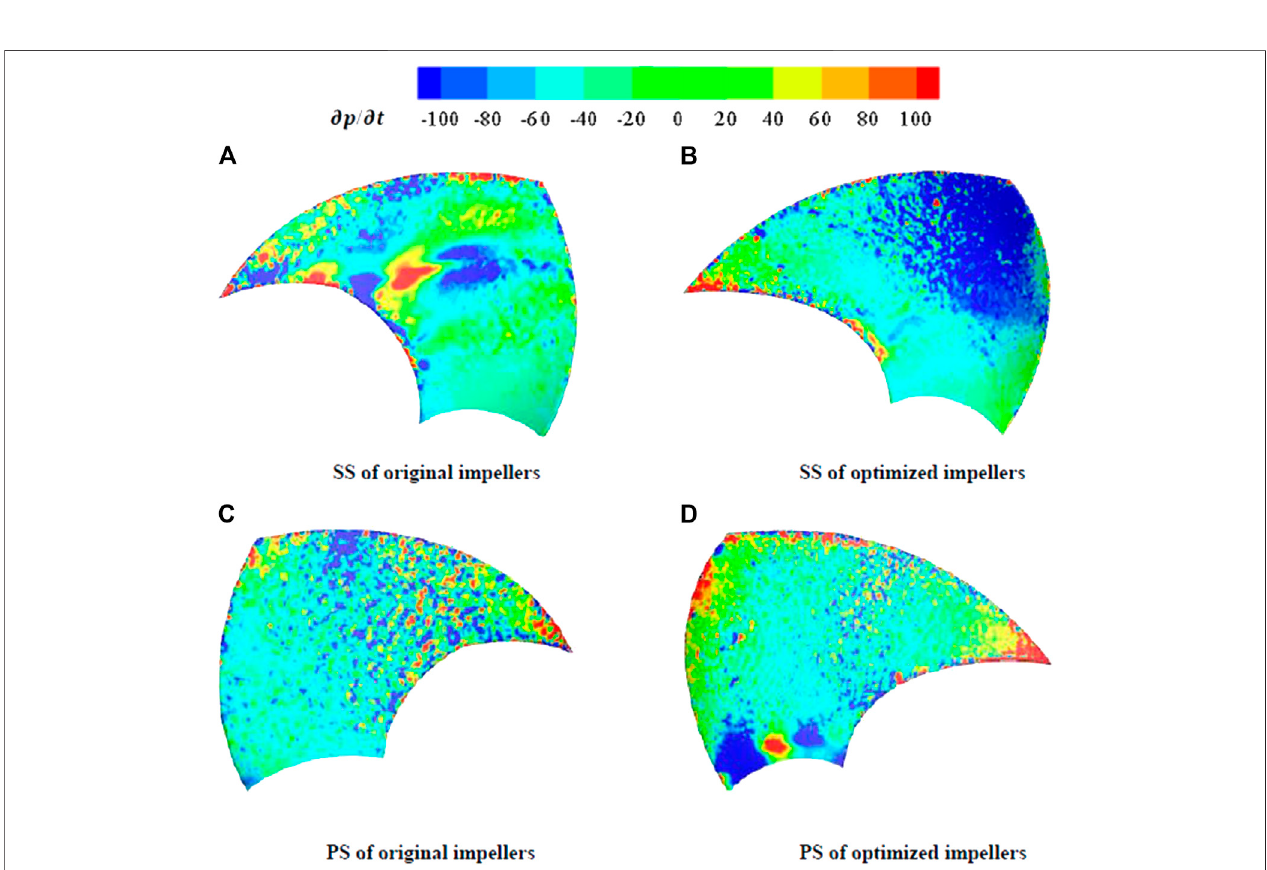
FIGURE19| Staticpressureover timederivativeonimpellers. (A) isSSoforiginalimpellers. (B) isSSofoptimized impellers. (C) isPSoforiginalimpellers. (D) isPS of optimized impellers.